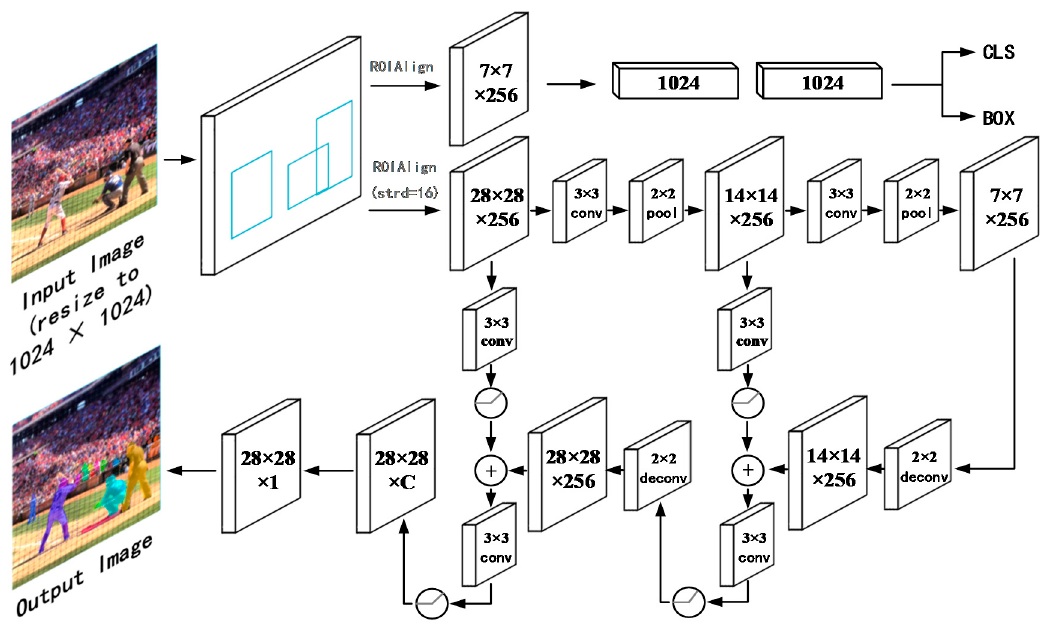
Figure 2. Network architecture of MR R-CNN.